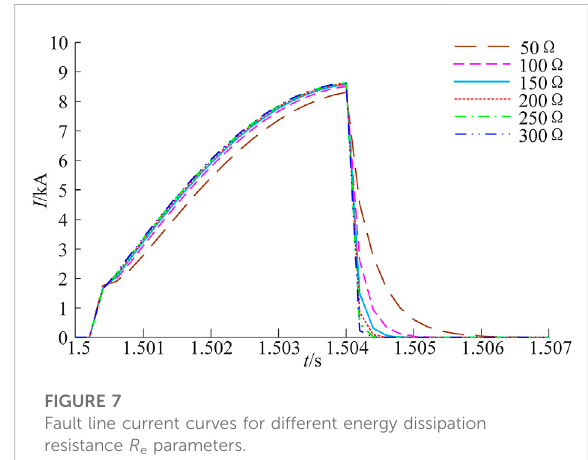
FIGURE 7 Fault line current curves for different energy dissipation resistance R e